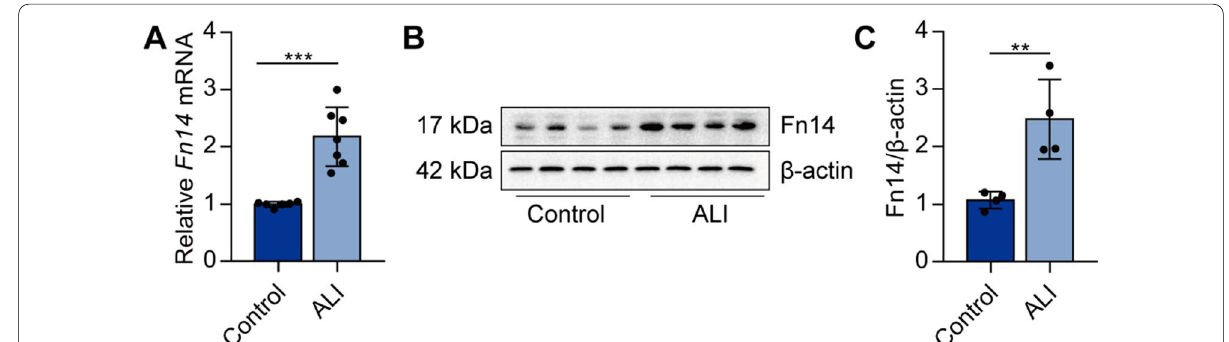
Fig. 1 Fn14 expression is increased in the lungs of ALI mice. C57BL/6J mice were intratracheally injected with LPS (5 mg/kg, i.t. ). Twelve hours later, the expression of Fn14 mRNA in the lungs was determined by real‑time PCR ( A, n 7). The protein expression of Fn14 in the lungs was determined = by Western blot ( B , C , n 4). Data are expressed as the mean SD. Differences between the two groups were determined by an unpaired t ‑test. = ± ** P < 0.01 and *** P <